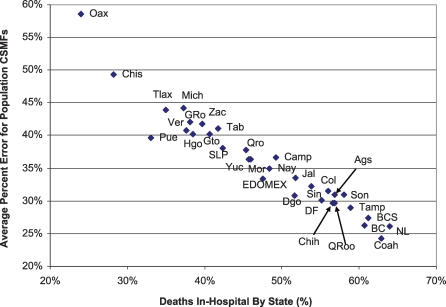
Average Relative Error in Population CSMFs when Based on Hospital CSMFs by State versus the Proportion of All Deaths Occurring in-Hospital, Mexico 1998–2005Each point represents a state in Mexico.Legend: Ags, Aguascalientes; BC, Baja California; BCS, Baja California Sur; Camp, Campeche; Chih, Chihuahua; Chis, Chiapas; Coah, Coahuila de Zaragoza; Col, Colima; DF, Distrito Federal; Dgo, Durango; EDOMEX, Estado de Mexico; GRo, Guerrero; Gto, Guanajuato; Hgo, Hidalgo; Jal, Jalisco; Mich, Michoacan de Ocampo; Mor, Morelos; Nay, Nayarit; NL, Nuevo Leon;Oax, Oaxaca; Pue, Puebla; Qro, Queretaro de Arteaga; QRoo, Quintana Roo; Sin, Sinaloa; SLP, San Luis Potosi; Son, Sonora; Tab, Tabasco; Tamp, Tamaulipas; Tlax, Tlaxcala; Ver, Veracruz-Llave; Yuc, Yucatan; Zac, Zacatecas.